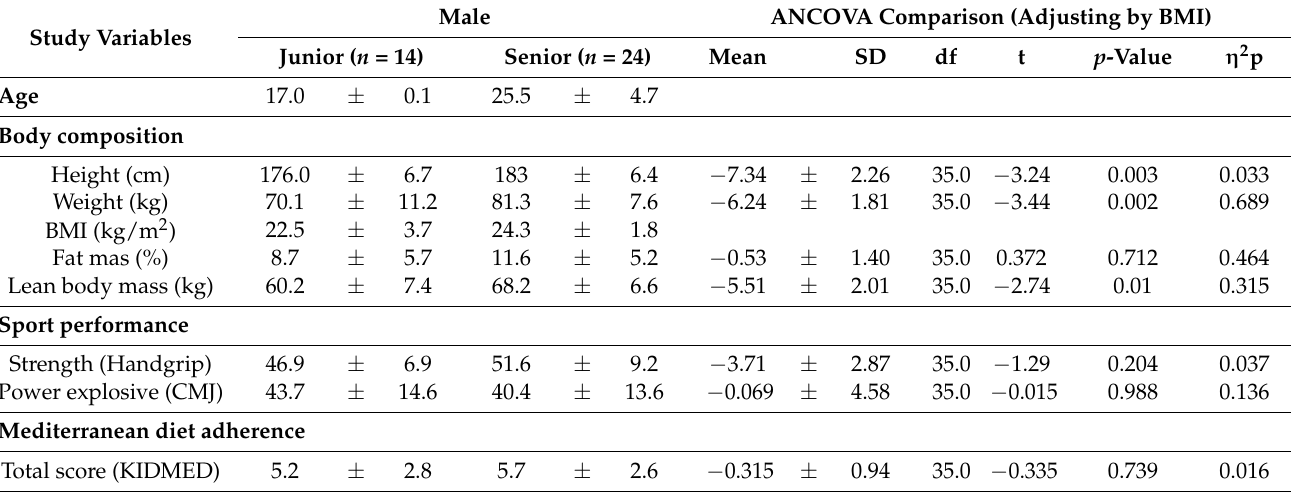
Table 4 shows mean and standard deviation values for the BC, sport performance and MD adherence of male BH players. Statistically significant differences ( p ≤ 0.05) were found between seniors and juniors in height, weight and LBM. Weight, height and LBM are higher in the senior group than in the junior group. Table 4. Male beach handball players descriptive and comparison (junior vs